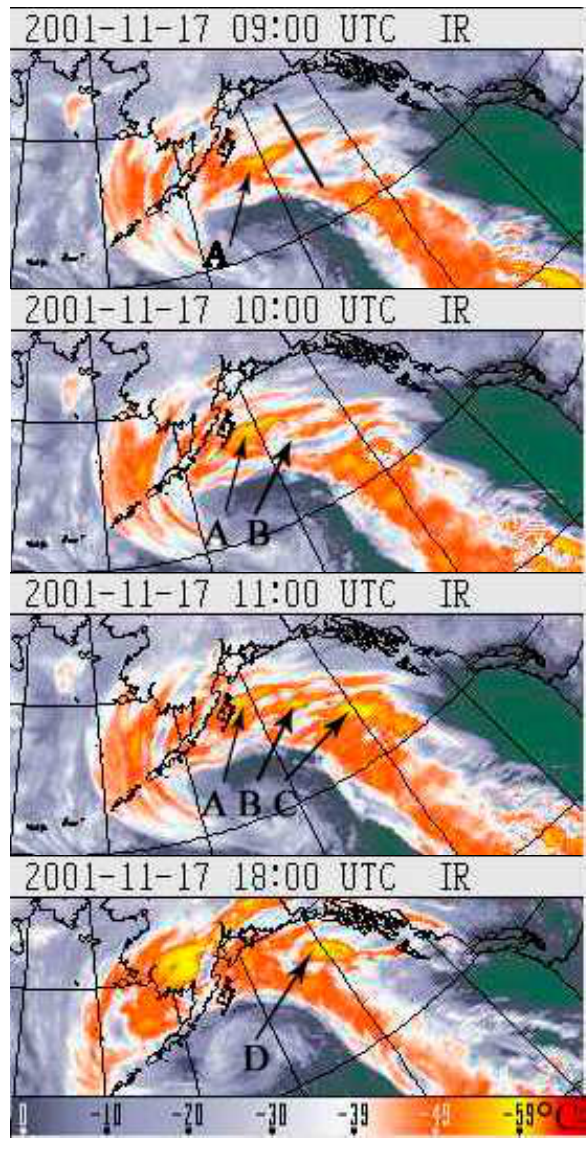
Fig. 8. The GOES-10 infrared images show cloud bands forming in the warm frontal zone of a mid-latitude cyclone. The bands A-C formed in sequence (top three panels). The band D started to form about 5 hours later. The heavy line segment (top panel) shows the location of the projection of a cross-section of troposphere that is considered in Fig 9.